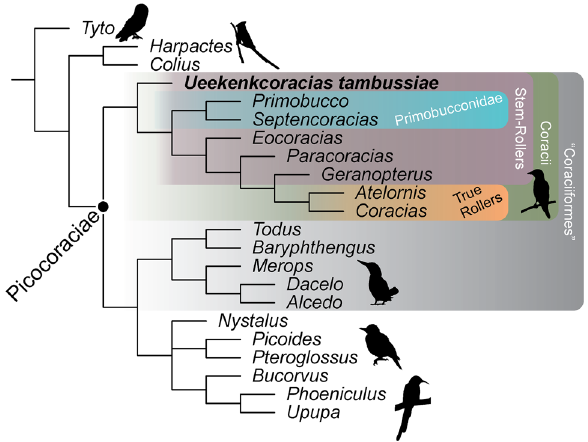
Figure 3. Phylogenetic relationships of Ueekenkcoracias tambussiae gen. et sp. nov. Bird silhouettes were taken from PhyloPic (PhyloPic—Free Silhouette Images of Life